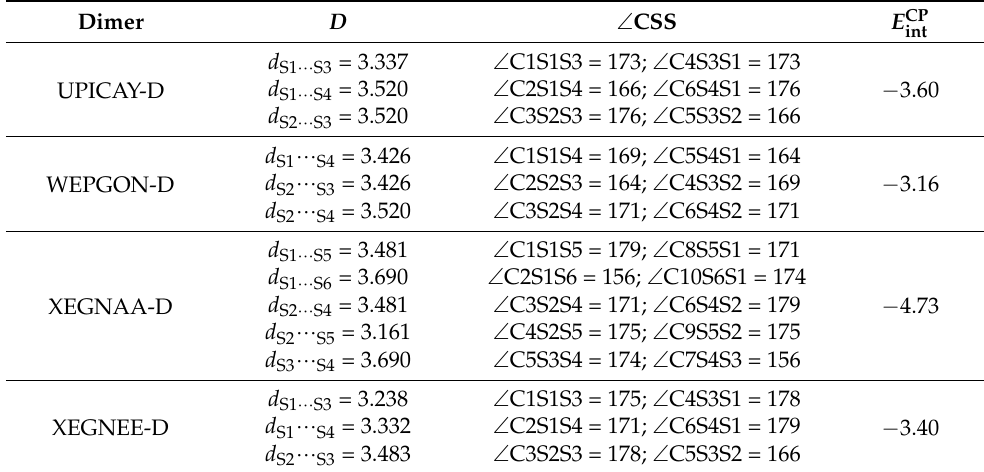
Table 1. The S ··· S interatomic distances ( d S ··· S , Å), C–S ··· S angles ( ∠ CSS, degree) and interaction energies ( E CP , kcal/mol) of the dimers int